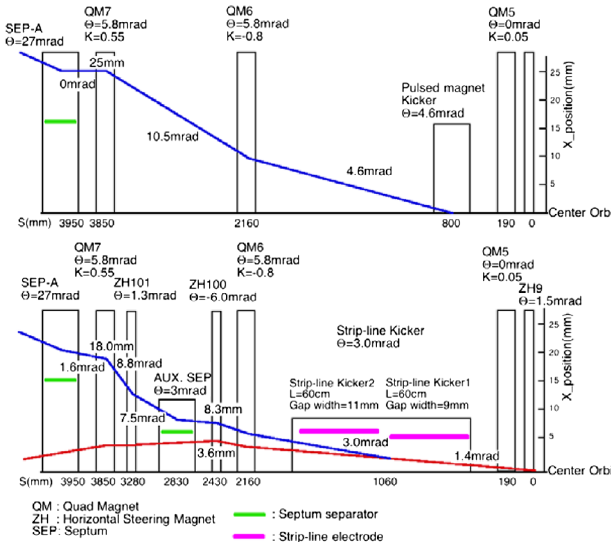
FIG. 4. Comparison of the beam extraction orbits (blue lines) in two systems: one with a pulsed magnet (upper) and one with a strip line (lower). The pulsed magnet kicker produces a 4.6 mrad kick angle and 25 mm displacement at the entrance of septum A.